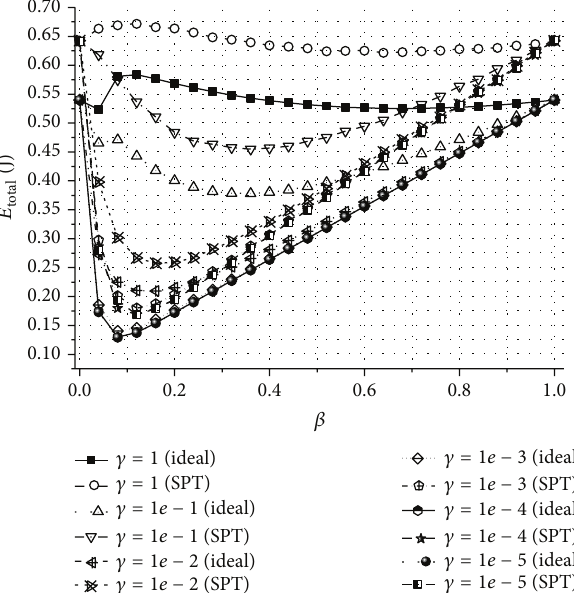
Figure 3: The total energy consumed by sensor nodes to transport all the information derived from one sensing event to the sink node ) for different 𝛽 and 𝛾 values when an ideal routing and a SPT ( 𝐸 total routing are used.